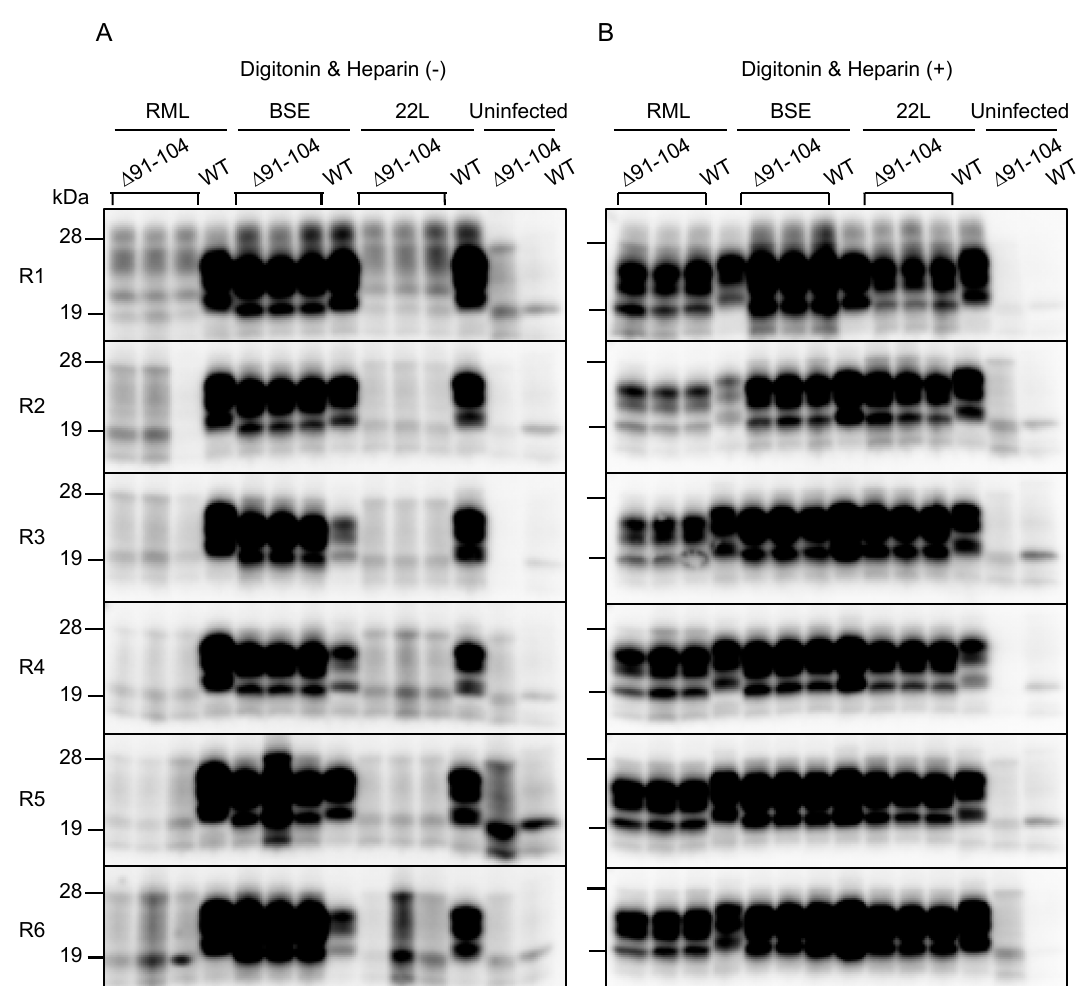
Figure 5. Protein misfolding cyclic amplification (PMCA) of PrP Sc ∆ 91–104. Baculovirus-derived recombinant WT PrP and PrP ∆ 91–104 were mixed with brain homogenates from RML-, BSE- and 22L-infected, terminal ill WT mice and subjected to PMCA from round 1 (R1) to R6 in the absence ( A ) or the presence ( B ) of digitonin and heparin. Uninfected brains were used as a negative control. 1 / 20 volume of each PMCA sample was then investigated for PrP Sc and PrP Sc ∆ 91–104 using western blotting (12% SDS-PAG) with T2 anti-PrP antibody after PK treatment.